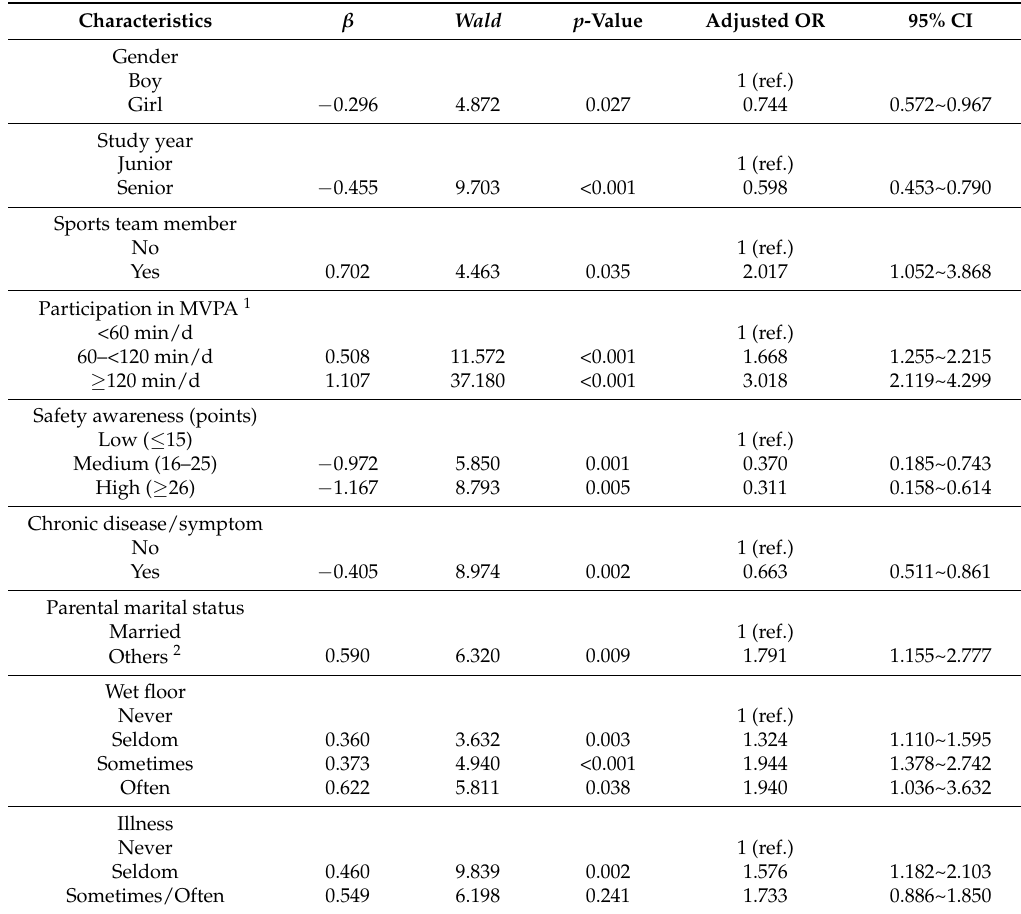
Table 3. Multivariate logistic regression to estimate risks of potential factors investigated for physical activity-related injury (PARI) among middle school students in Southern